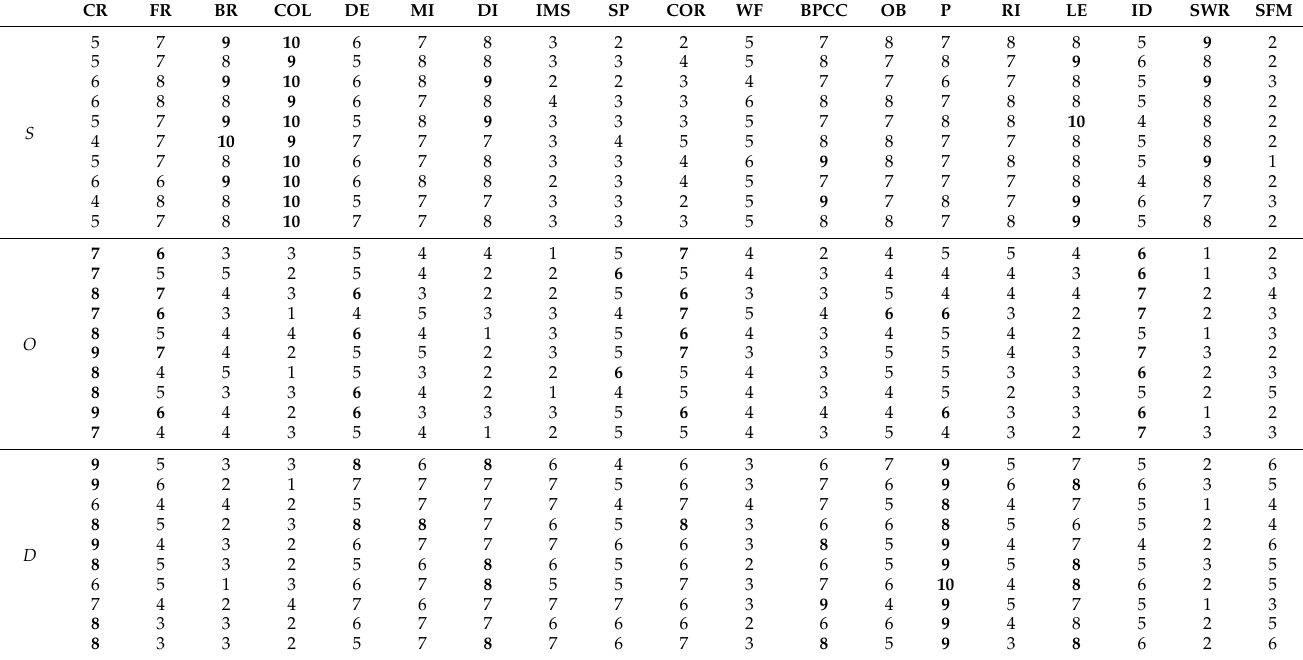
Table 8. Sewer pipeline failure pattern evaluation by experts (The extreme values in the table (greater than or equal to 9 for part S, greater than or equal to 6 for part O, and greater than or equal to 8 for part D) are marked in bold